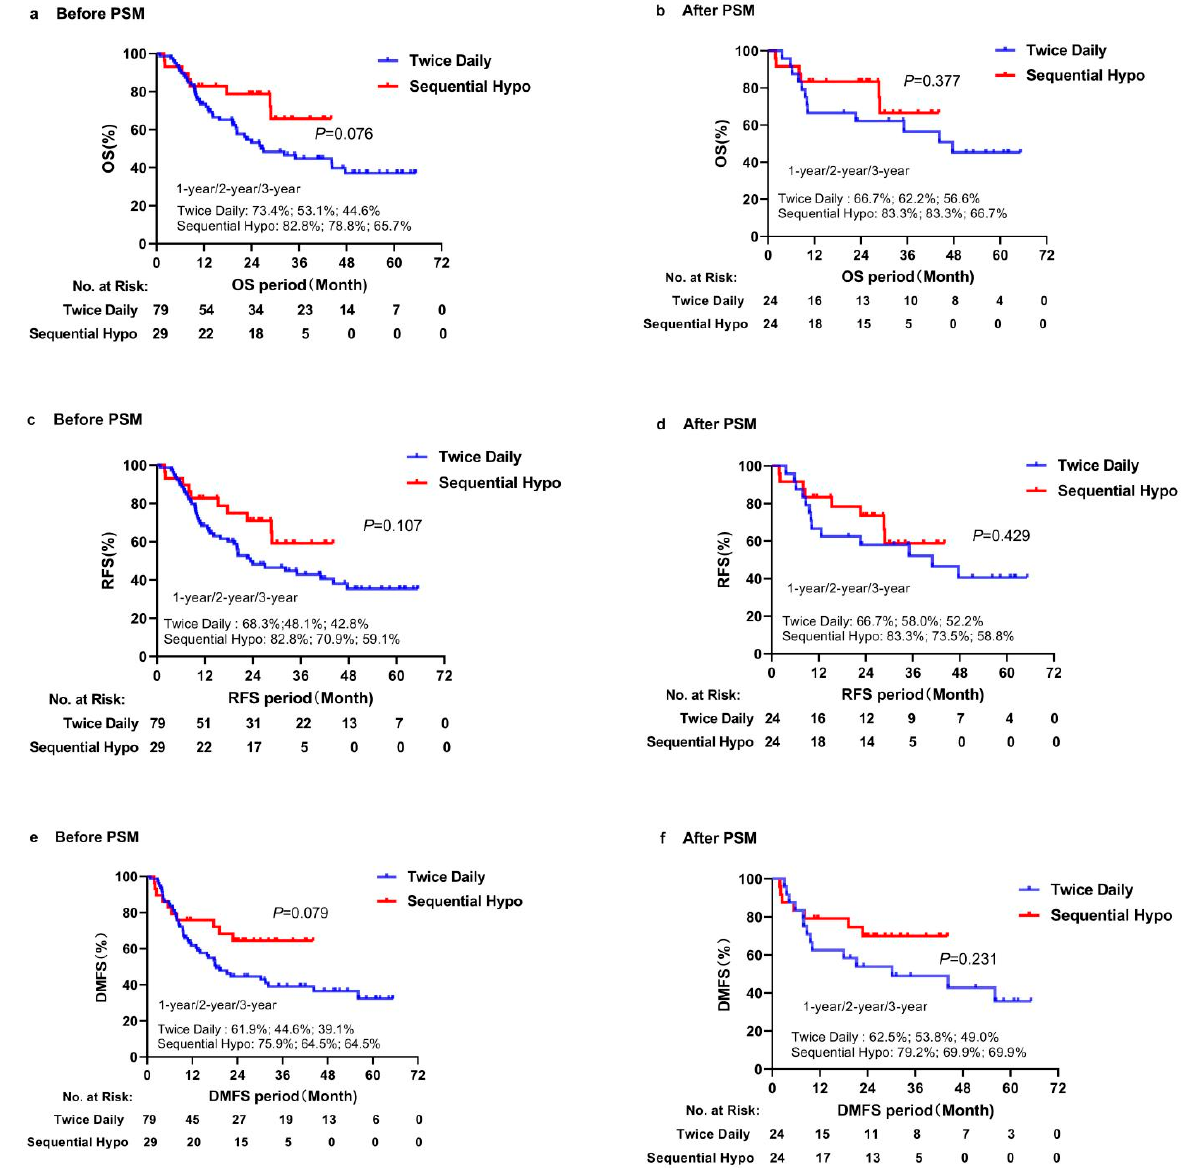
Figure 1. Kaplan–Meier analysis estimates the median survival time and the 1-, 2-, and 3-year OS, RFS and DMFS in different doses/fractions (sequential hypofractionated versus twice-daily): ( a ) OS before PSM; ( b ) OS after PSM; ( c ) RFS before PSM; ( d ) RFS after PSM; ( e ) DMFS before PSM; ( f ) DMFS after